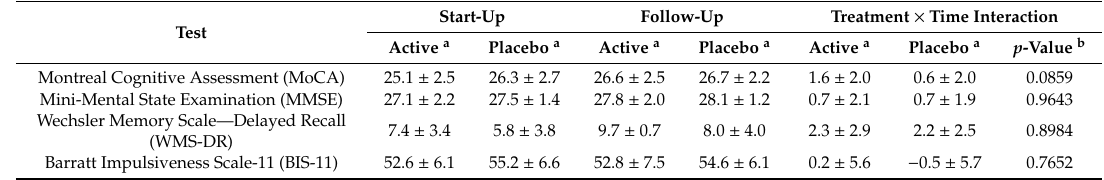
Table 3. Two-way analysis of treatment × time interaction in psychometric tests of active and placebo groups for total